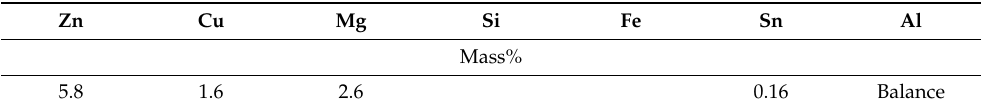
Figure 2. Backscattered electrons mode SEM image of Alumix 431D powder mixture: cross sections of air-atomised aluminium (monolitic grey) and master alloy (light) particle are visible ( a ) general image, ( b ) detailed image showing eutectic type mictrostructure of master alloy. Table 1. Composition of Alumix 431D grade powder without lubricant produced by ECKA Granules GmbH